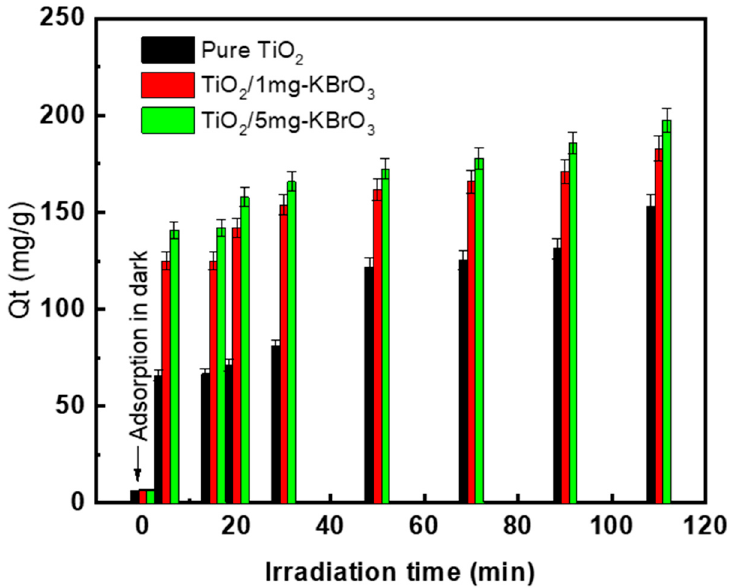
Figure 8. The degradation quantity of phenol red in mg/g (PR in mg for each g of TiO 2 ) for pure TiO 2 , TiO 2 /1 mg-KBrO 3 , and TiO 2 /5 mg-KBrO 3 samples.